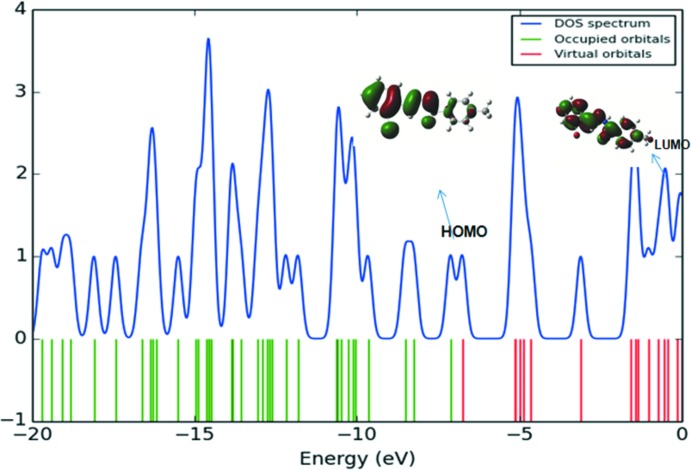
The density of states (DOS) spectrum of the compound.